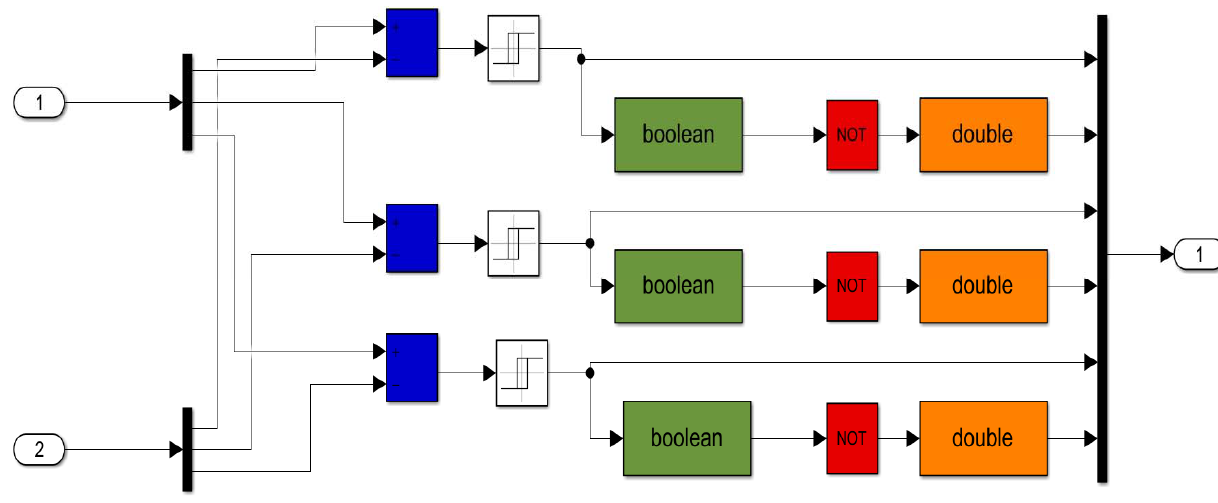
Figure 7. Hysteresis technique for pulsing modeling.